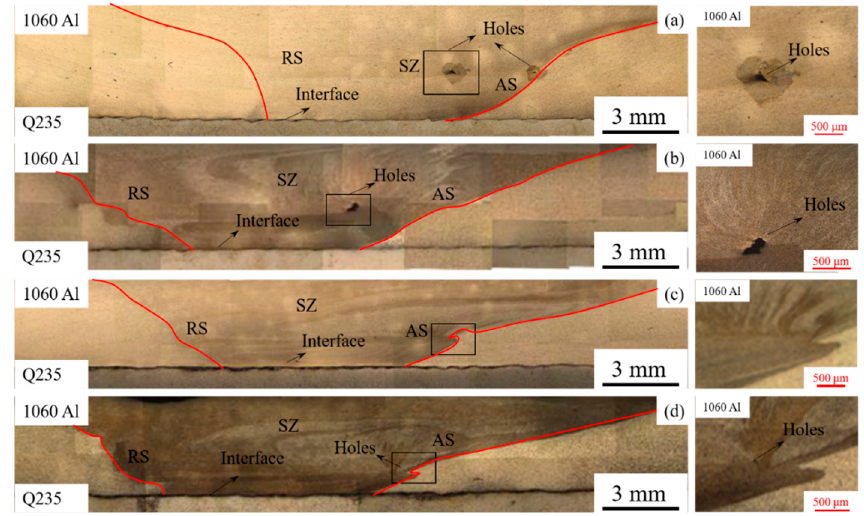
Figure 3. Microstructures of the repair zone for 1060Al/Q235 composite plate after M-FSP with different passes: ( a ) single pass; ( b ) two passes; ( c ) three passes; ( d ) four passes. Table 2. Quantities and area of holes in the repair zone for 1060Al/Q235 composite plate after FSP with different passes.